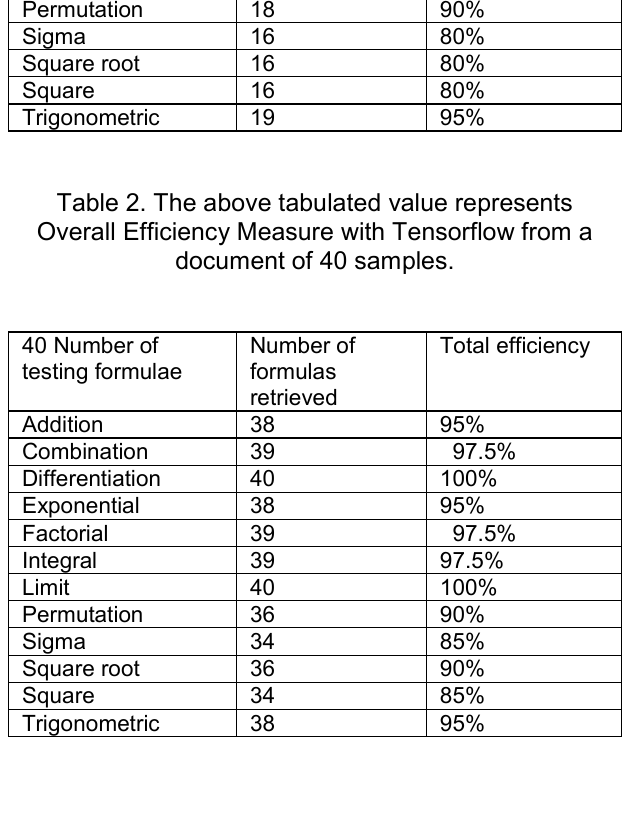
Table 3. The above tabulated value represents overall Efficiency Measure with Tensorflow from a document of 60